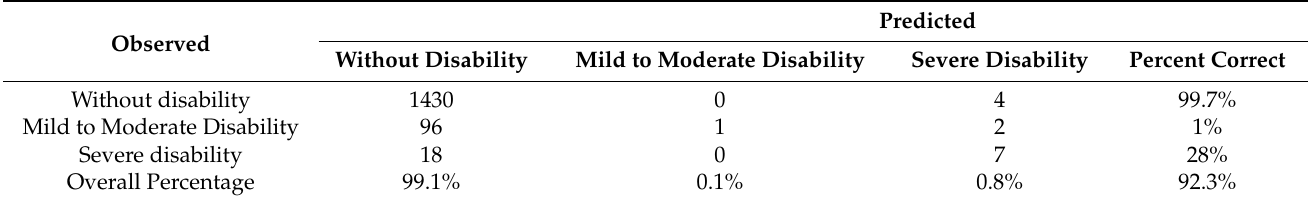
Table 3. Power of classification of job opportunities for people with disabilities in Chile model.